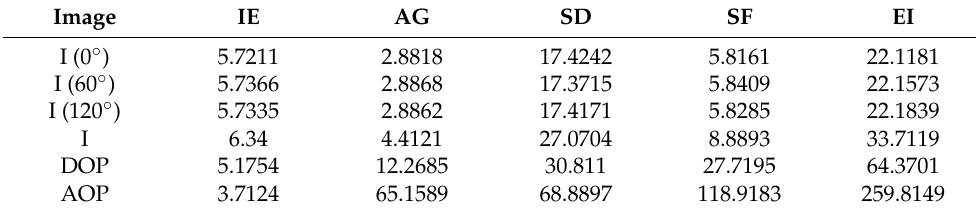
Table 2. Objective evaluation index of monocrystalline silicon solar panel.